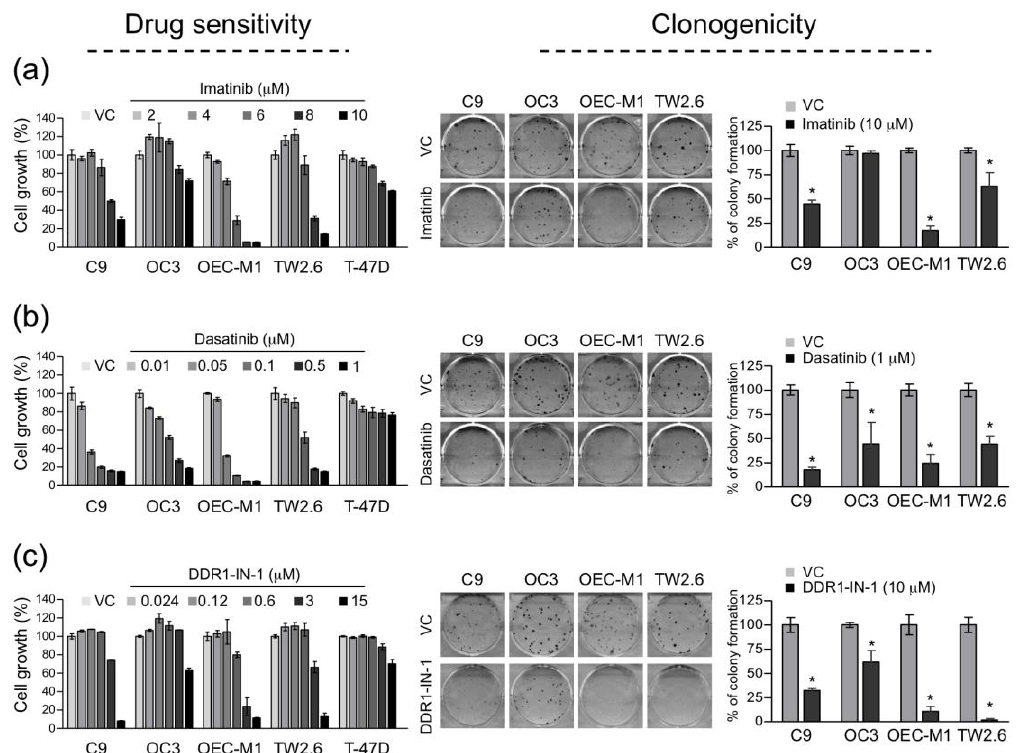
Figure 4. DDR1 kinase inhibitors suppressed OSCC cell growth and clonogenicity. Drug sensitivity (left part in each panel) was determined by treating cells with 2–10 µ M imatinib. ( a ) 0.01–1 µ M dasatinib, ( b ) or 0.024–15 µ M DDR1-IN-1 ( c ) for 3 d, followed by WST-1 proliferation assay. VC, vehicle control (H 2 O for imatinib; DMSO for dasatinib and DDR1-IN-1). For each treatment, data are presented as mean ± SD from quadruplicate wells. Breast cancer cell line T-47D served as a control. Similar results were obtained from two independent experiments; one set of data is shown. Clonogenic survival assay (right part in each panel) was determined by treating cells in quadruplicate wells with 10 µ M imatinib, ( a ) 1 µ M dasatinib ( b ) or 10 µ M DDR1-IN-1 ( c ) for 24 h, followed by cultivating cells in drug-free media for an additional 10–14 d. Representative photographs of crystal violet staining for each treatment are shown. Colony counts from two independent experiments are presented as mean ± SD, with the VC group set to 100%. * p <